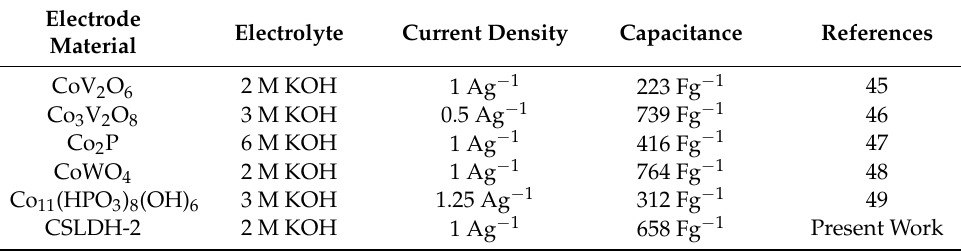
Table 2. Comparative performances including the different concentration of the